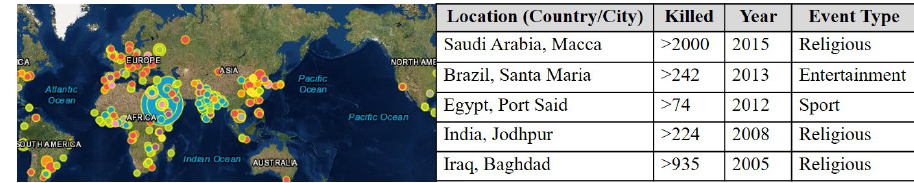
Figure 1. Crowd caused disasters around the global [5].